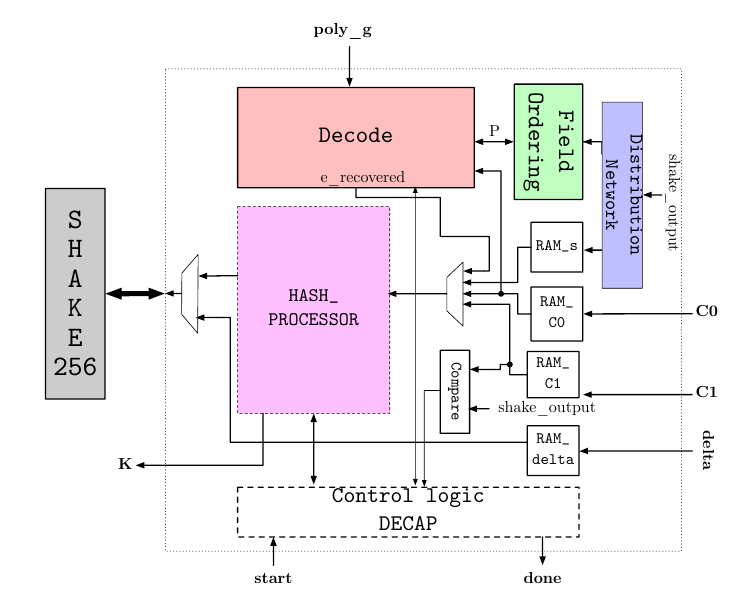
Figure 20: Hardware design of Decap module interfaced with SHAKE256